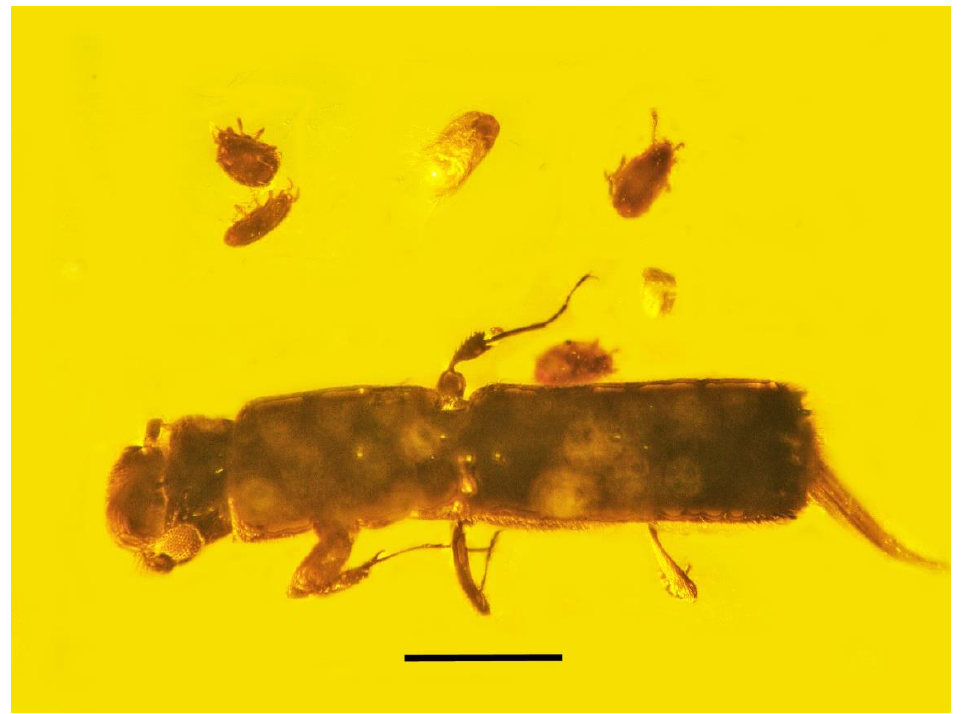
Figure 3. Large mites (Arachnida: Acari) that detached from a platypodine beetle (Coleoptera: Curculionidae: Platypodinae) in Dominican amber. Scale bar = 780 µm.